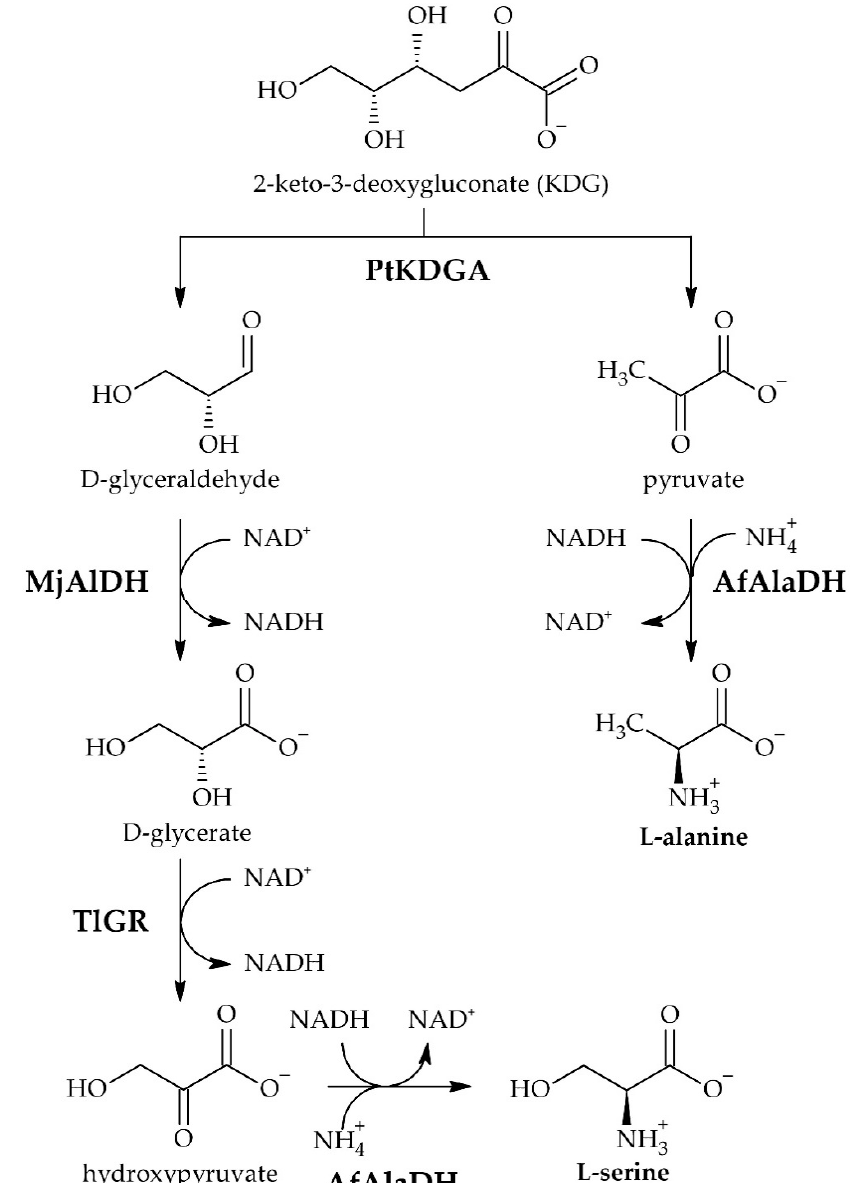
Figure 1. Enzyme cascade reactions for the synthesis of L-alanine and L-serine out of the sugar degradation product KDG. Legend: KDG (2-keto-3-deoxygluconate), NAD + /NADH (Nicotinamide adenine nucleotide). Biocatalysts: PtKDGA (2-keto-3-desoxygluconate aldolase from Picrophilus torridus ), MjAlDH (aldehyde dehydrogenase from Methanocaldococcus jannaschii ), TlGR (glyoxylate reductase from Thermococcus litorialis ), AfAlaDH (alanine dehydrogenase from Archaeoglobus fulgidus